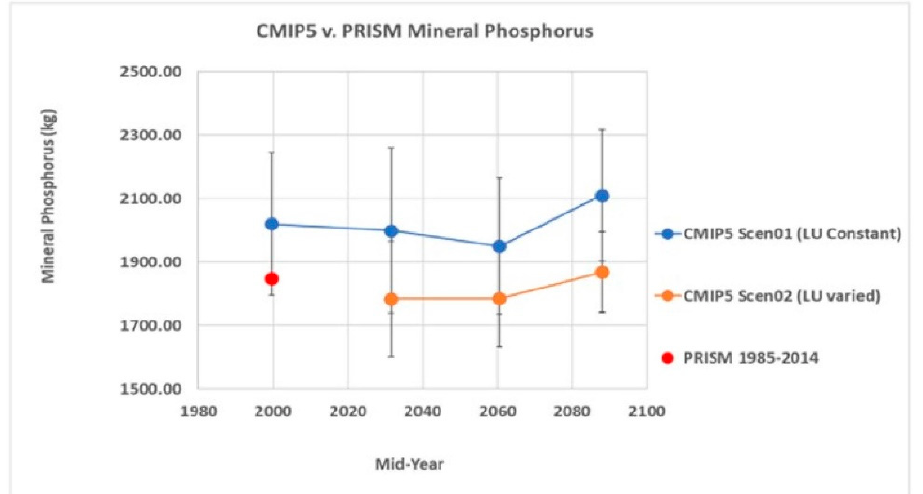
Figure 8. PRISM vs. average of 20 CMIP5 GCMs mineral phosphorus (2018–2100).